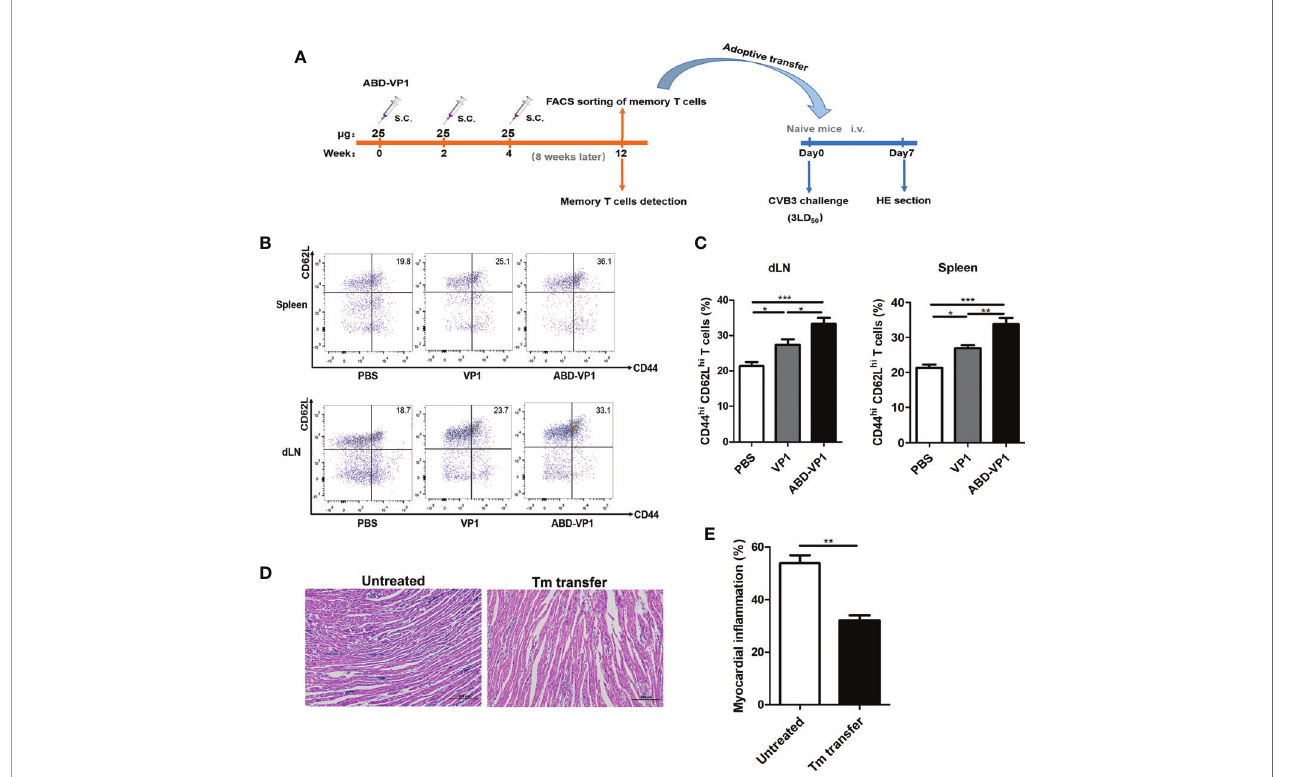
FIGURE 6 | Adoptive transfer of memory T cells derived from ABD-VP1-immunized mice protected naive mice against CVB3 challenge. (A) Timeline of memory T cell detection and transfer. (B) Percentages of CD44 hi CD62 hi memory T cells in spleens and dLNs of immunized mice were detected 8 weeks after the fi nal immunization. (C) Statistical analysis of (B) . (D) Naive mice were adoptively transferred with memory T cells derived from ABD-VP1-immunized mice at the day of CVB3 (3LD 50 ) infection, and the heart histomorphological changes were observed 7 days later. (E) Statistical analysis of (D) . Each group contained 6 mice. *P < 0.05; **P < 0.01; ***P <